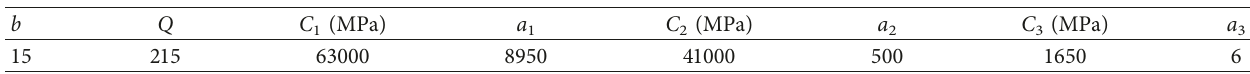
Table 2: Parametric values of Chaboche kinematic hardening model for 304 stainless steel specimens